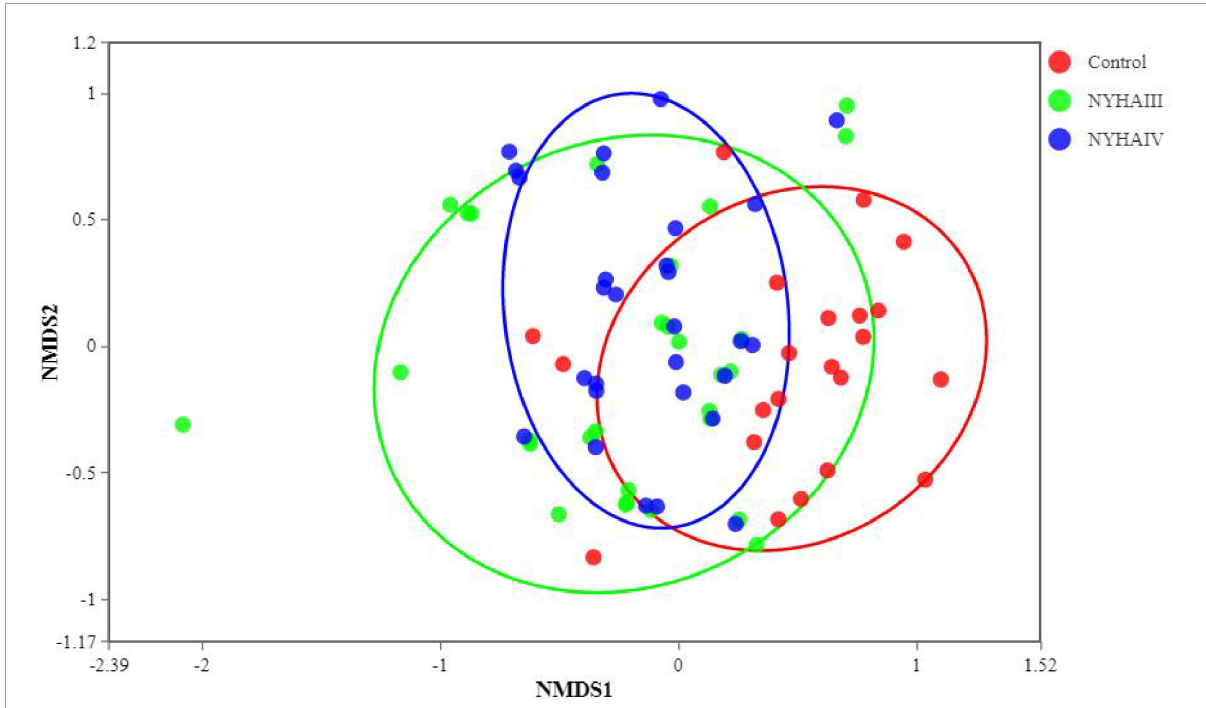
FIGURE3 Non-metric multidimensional scaling (NMDS) analysis among Control, New York Heart Association (NYHA) class III, and NYHA class